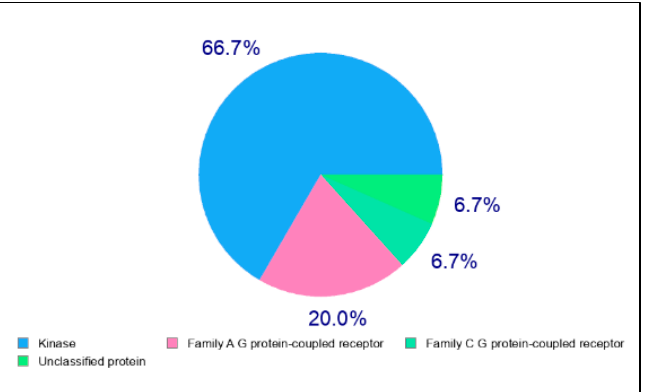
Figure 2. Percentage affinity of the designed compounds for kinases rather than other targets.